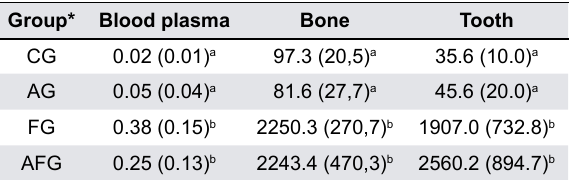
Table 3- Mean (SD) concentration of F, expressed as μg/g of bone or tooth and as μg/mL of